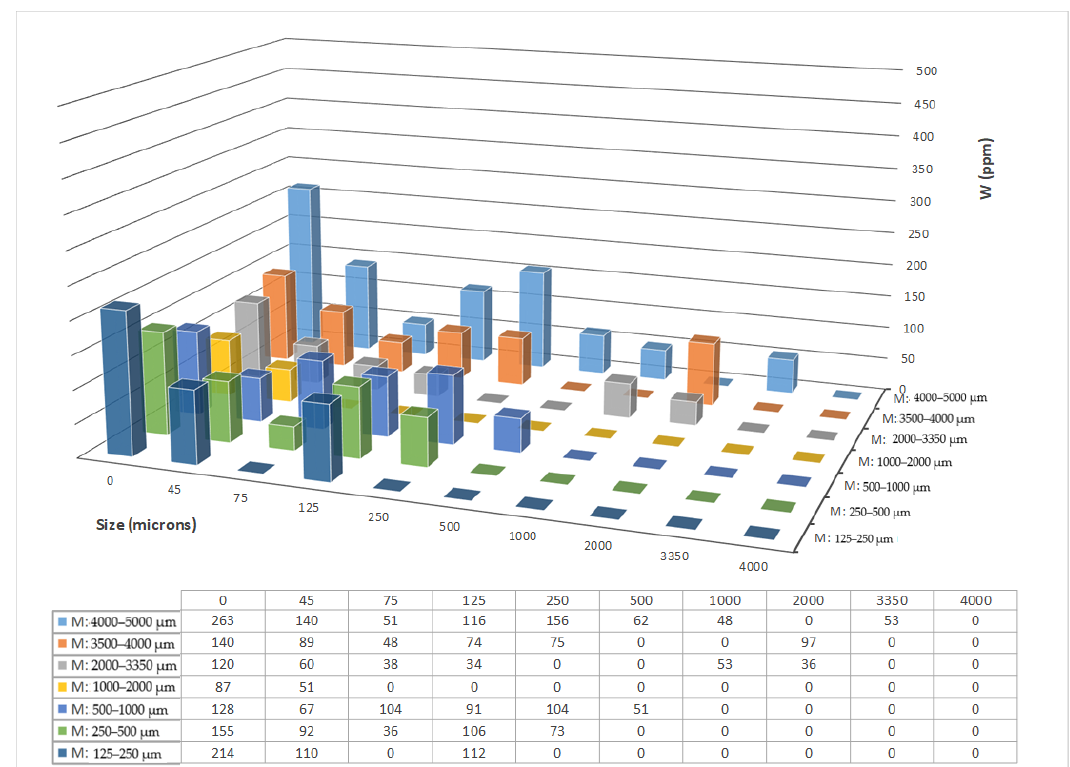
Figure 9. Evolution of the W grade in the product with respect to the monosizes and their grain size fractions for 70% Nc .